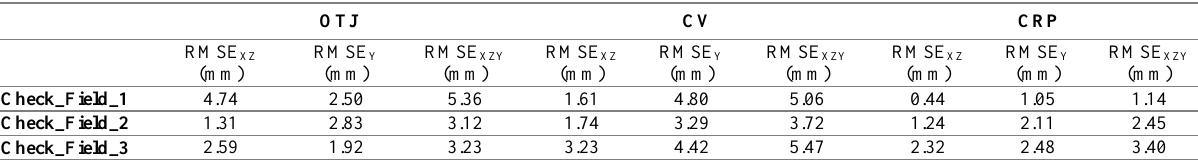
Table 5: RMSE on check-point measurement